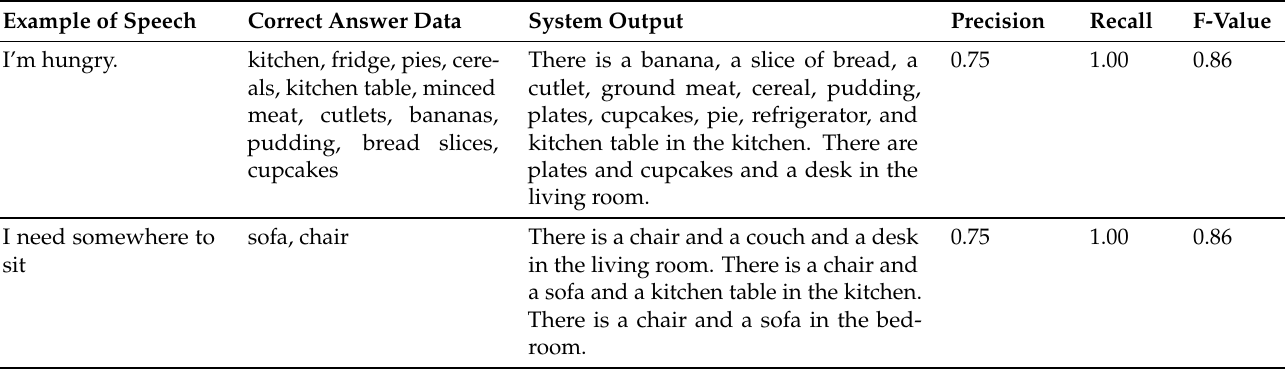
Table A1. Examples of speech data and system